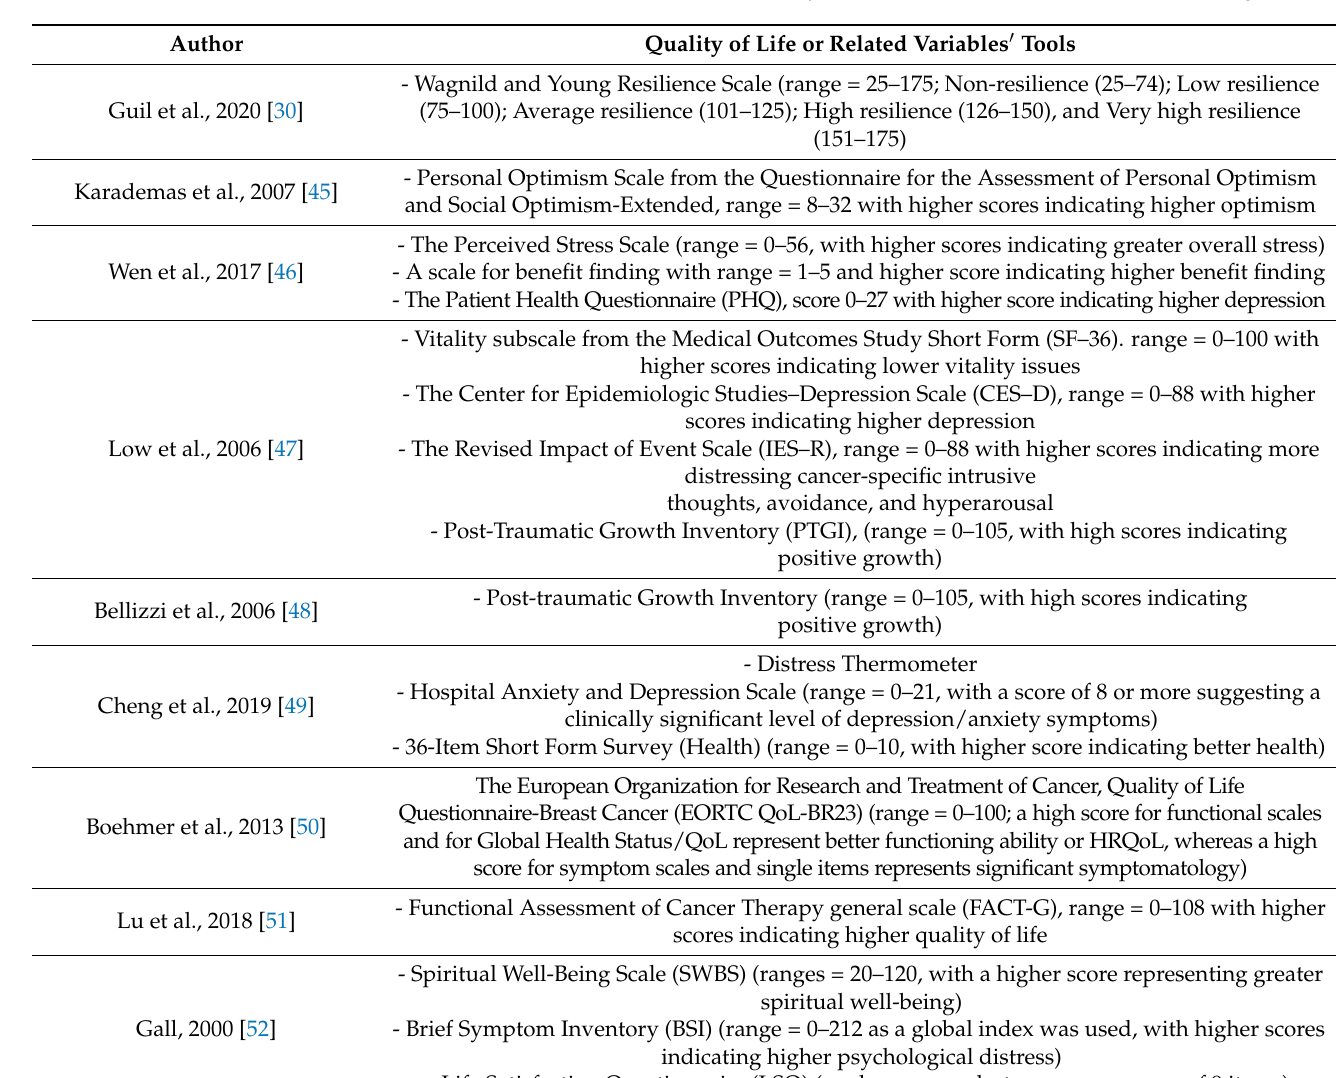
Table 3. List of the tools used to assess Quality of Life or related variables and related